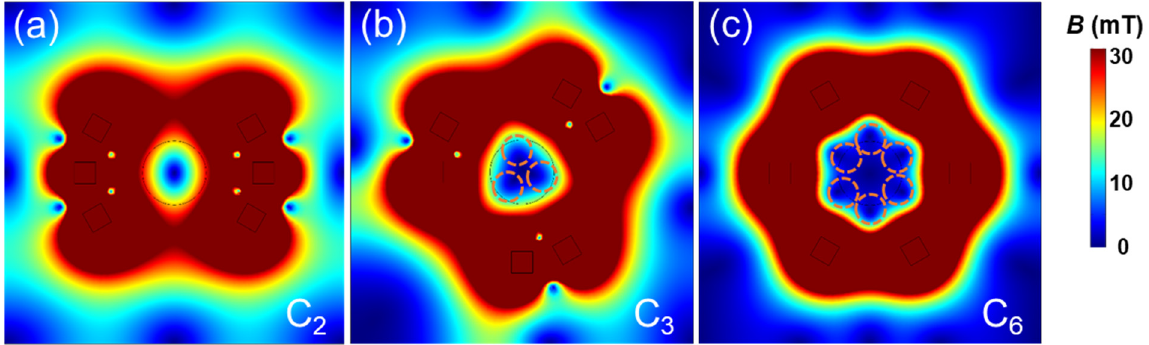
Figure 6. Magnetic flux density distribution in middle cross-section (x-y plane) of 6-magnet M-MagLev system with C 2 -symmetry ( a ), C 3 -symmetry ( b ), and C 6 -symmetry ( c ). The red dotted circles in ( b , c ) indicate the multiple stable positions.